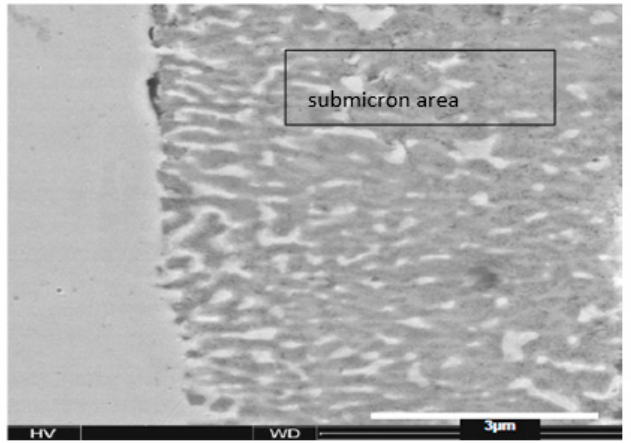
Figure 12. The lamellae aspect of the coating is typical of structure produced on the matrix NiCrAlY by receive